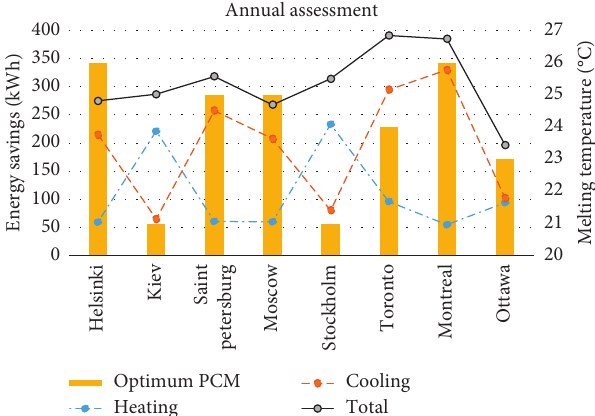
Figure 12: Annual heating, cooling, and total savings for all cities with optimum PCM melting